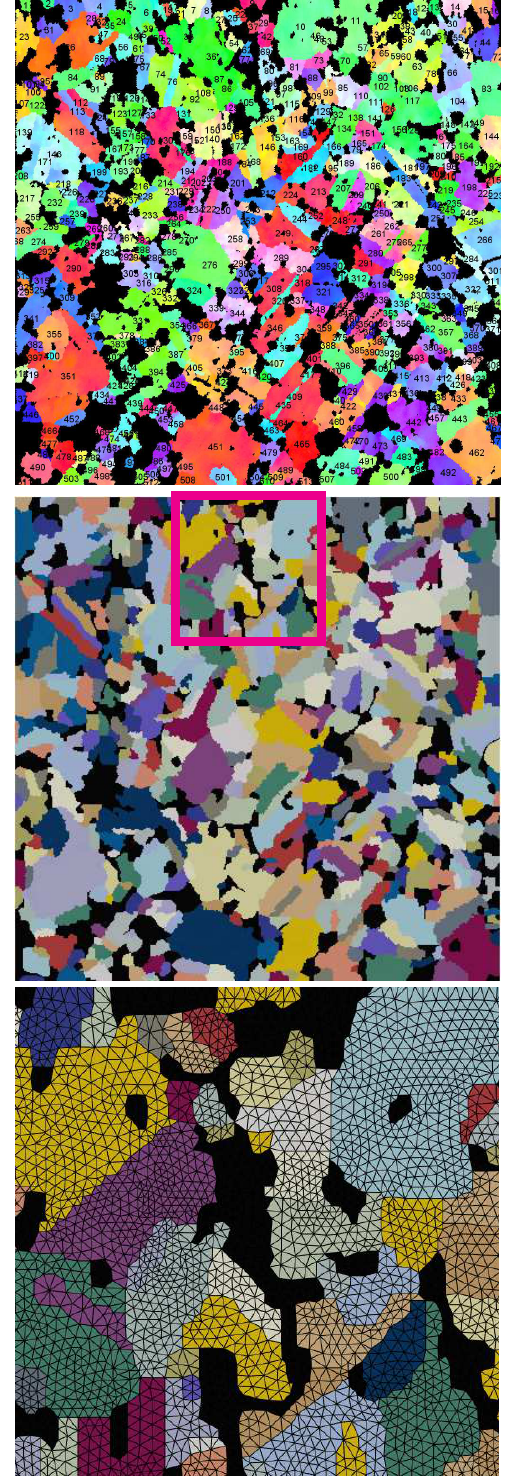
Fig. 7: (a) Dimensions of micro, macrostructures, and the tran- sition zone in the two-scale simultaneous FE simulation; (b) the meshing of the whole structure; (c) the meshing in the transition zone; (d) part of the meshing in the transition zone and the real